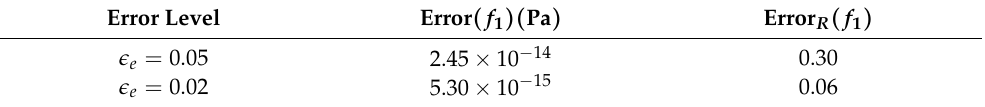
Figure 10. Recovery of a discontinuous load. ( a ) Sections of the recovered load on the line y = L Y /3. Error level (cid:101) e = 0.05. ( b ) Sections of the recovered load on the line y = L Y /3. Error level (cid:101) e = 0.02. Table 4. Absolute and relative errors for the recovery of a discontinuous